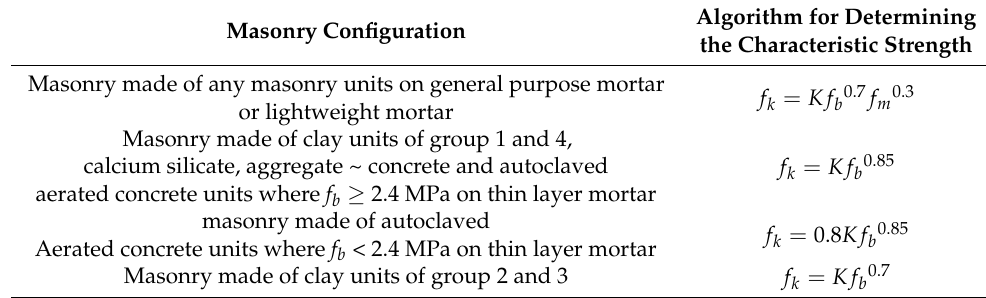
Table 1. Provisions concerning the characteristic compressive strength of masonry according to polish annex of the PN-EN 1996-1-1 [4]. Masonry Configuration